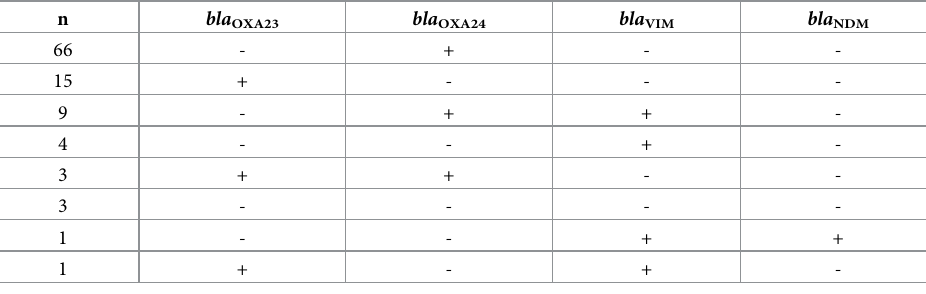
Table 7. Distribution of carbapenemase-encoding genes among A . baumannii complex a .